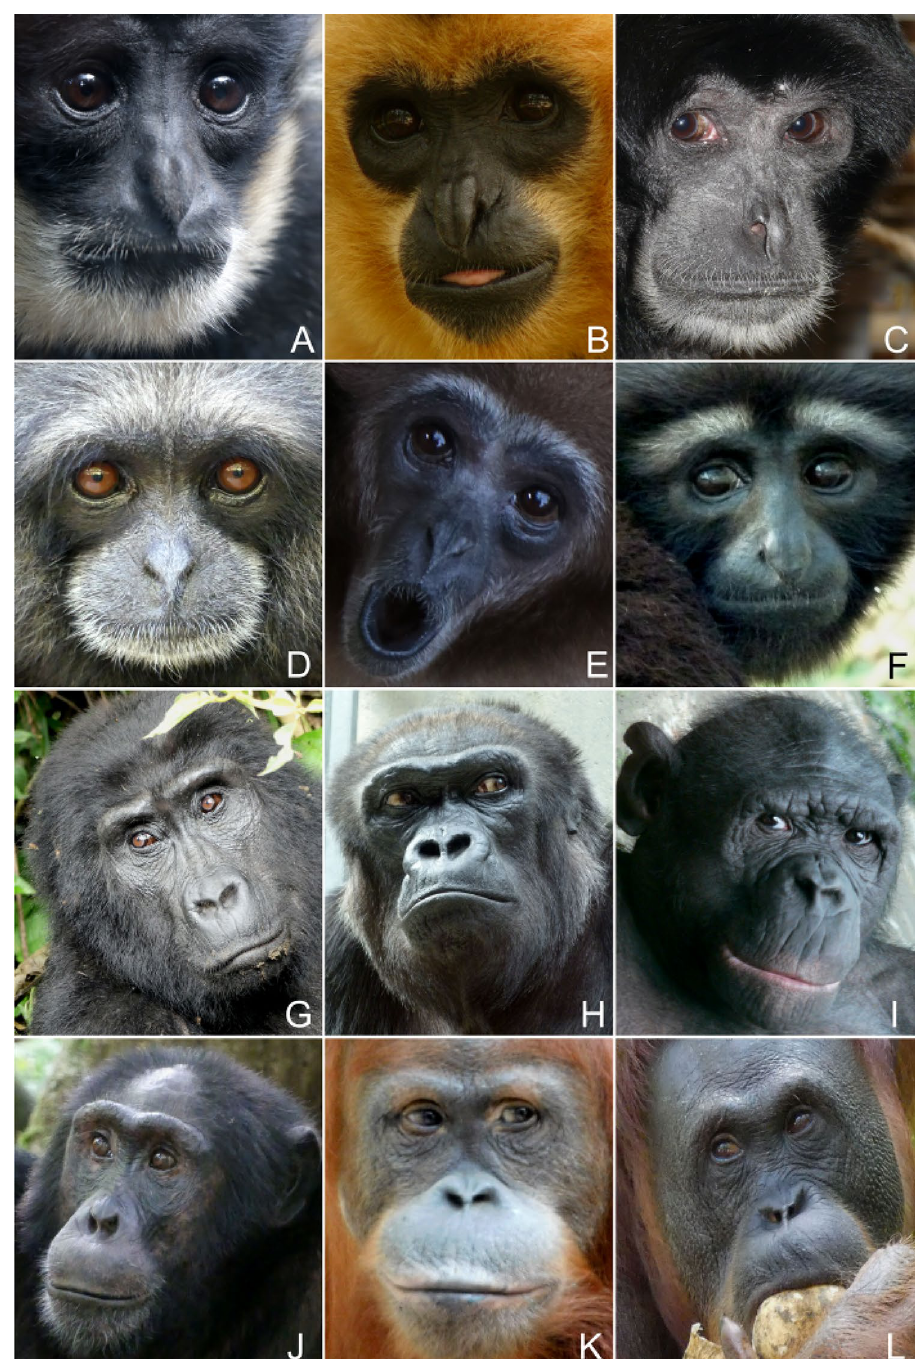
Figure 2. Typical external appearance of the eye in representatives of the seven non-human ape genera (superfamily Hominoidea). Note the difference in scleral exposure between gibbons ( A – F ) and great apes ( G – L ) ( A ) Southern white-cheeked gibbon ( Nomascus (leucogenys) siki ). ( B ) Southern yellow-cheeked gibbon ( Nomascus gabriellae ). ( C ) Siamang ( Symphalangus syndactylus ). ( D ) East Bornean gray gibbon ( Hylobates funereus ). ( E ) White-handed gibbon ( Hylobates lar ). ( F ) Gaoligong hoolock gibbon ( Hoolock tianxing ). ( G ) Eastern gorilla ( Gorilla beringei ). ( H ) Western gorilla ( Gorilla gorilla ). ( I ) Bonobo ( Pan paniscus ). ( J ) Chimpanzee ( Pan troglodytes ). ( K ) Sumatran orangutan ( Pongo abelii ). ( L ) Bornean orangutan ( Pongo pygmaeus ). Photo credit: A, E—Miriam Lindenmeier (used with permission); K—Kai R. Caspar; all remaining pictures—Thomas